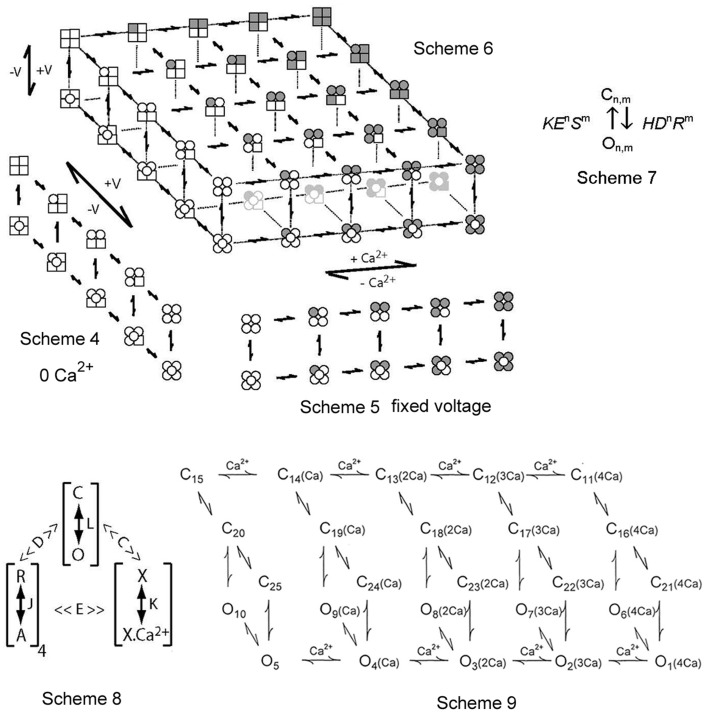
Two-tiered gating mechanisms for BK channels. Scheme 4 is for voltage only gating, Scheme 5 is for Ca2+ only gating, and Scheme 6 combines the two for joint gating by both voltage and Ca2+. The upper tiers are closed states and the lower tiers open states. The four subunits for each state are depicted. A filled subunit has a bound Ca2+ and a round subunit has an activated voltage sensor (from Rothberg and Magleby, 1999, 2000). Scheme 7 presents a constrained approach of representing the allosteric action of voltage and Ca2+ on the opening and closing transitions between the closed and open tiers in Schemes 4–6. Scheme 8 is a shorthand method devised by Horrigan and Aldrich (2002) to describe Scheme 6 in terms of effective equilibrium constants. Scheme 9 from Rothberg and Magleby (2000) is a subset of Scheme 6. See text for detailed descriptions of all these schemes.